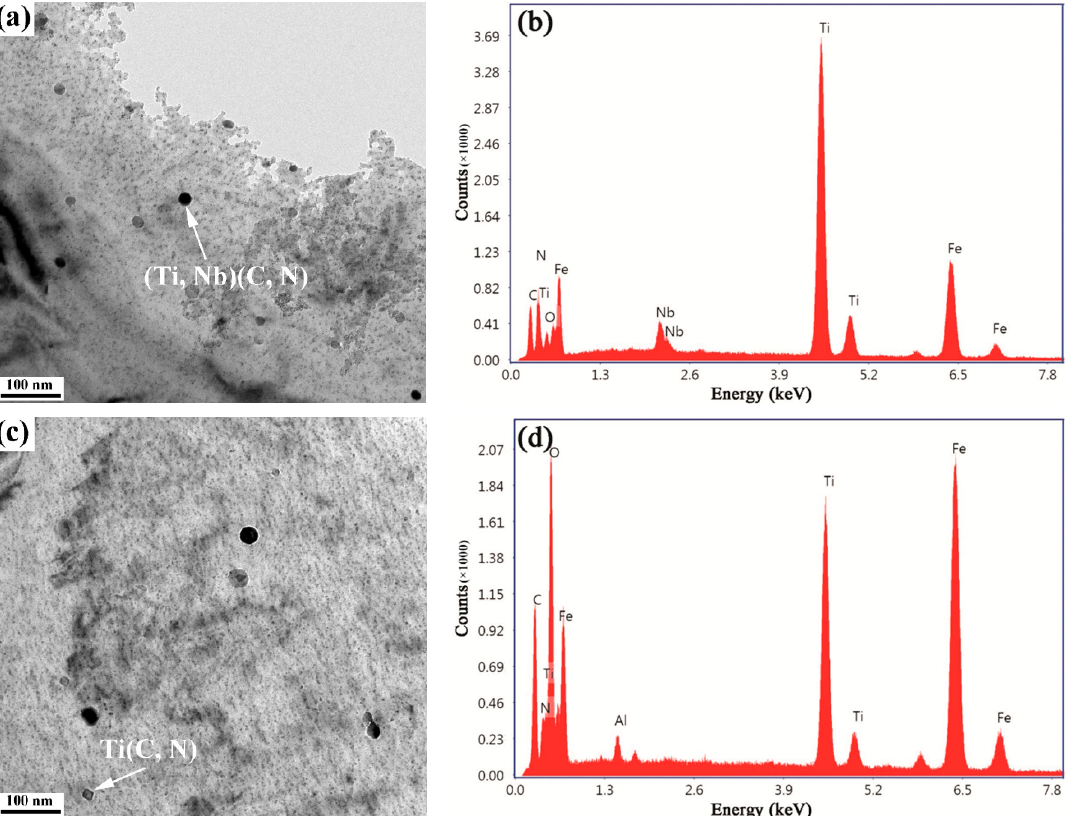
Figure 4. TEM morphologies of precipitates in the specimen before heating displaying ( a ) round (Ti, Nb) (C, N) and ( c ) square Ti (C, N); panels ( b , d ) are the EDS spectra of the precipitate shown in panels ( a , c ), respectively.